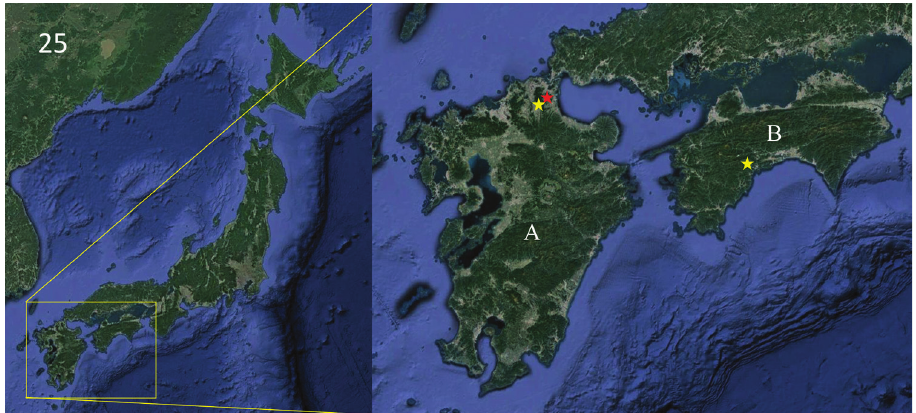
Figure 25. Map of Japan highlighting Kyushu ( A ) and Shikoku ( B ) Islands. The red star indicates the location of Mejiro-do Cave (habitat of P. daidarabotchi ), while the yellow stars indicate the location of Goya Daiichi Shonyu-do (Kyushu) and Inaba-do (Shikoku) caves, both habitats of P. nipponica. Table 3. Pacificampa nipponica Sendra, sp. n., length of the body, antennomeres and metathoracic leg including their segments, and cerci (units in mm); and, number of antennomeres. Segment length of metathoraci leg Total Body Antennae Specimen antennomeres metathoracic length length lengthCoxa Trochanter Femur Tibia Tarsus paratype SH02 juvenile SH02 and male IN01 and 0+1 sla in female IN02) on IV; 1+1 ma, 1+1 la and